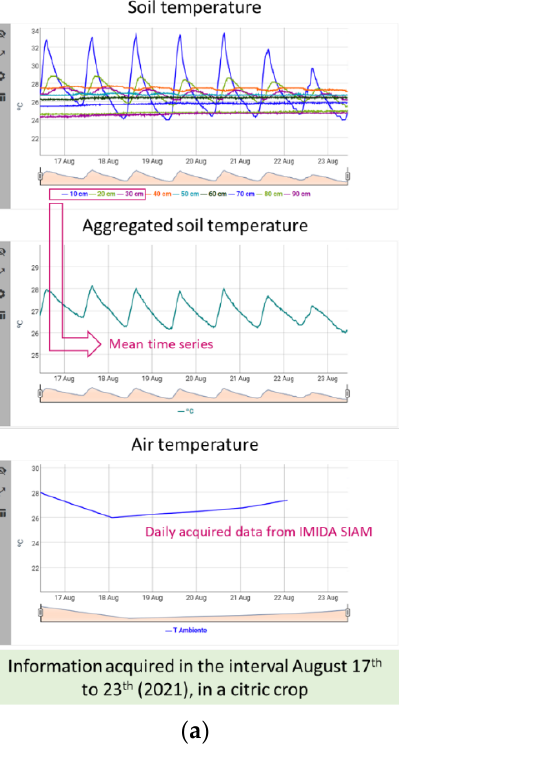
Figure 9. Information provided by the WEB application: ( a ) Charts shown when the Temperature tab is active. ( b ) Information regarding the plot. Text translation and icon buttons are highlighted.